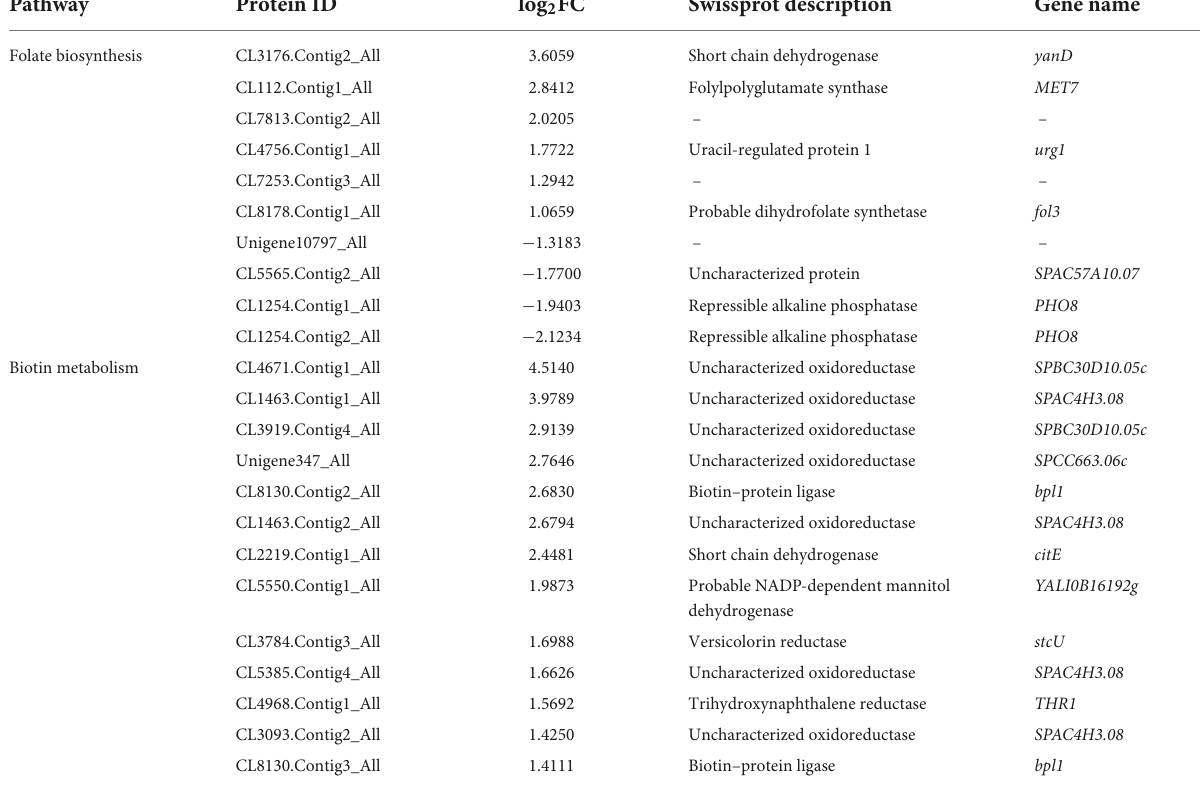
TABLE 2 Differentially abundant proteins in “folate biosynthesis” and “biotin metabolism”